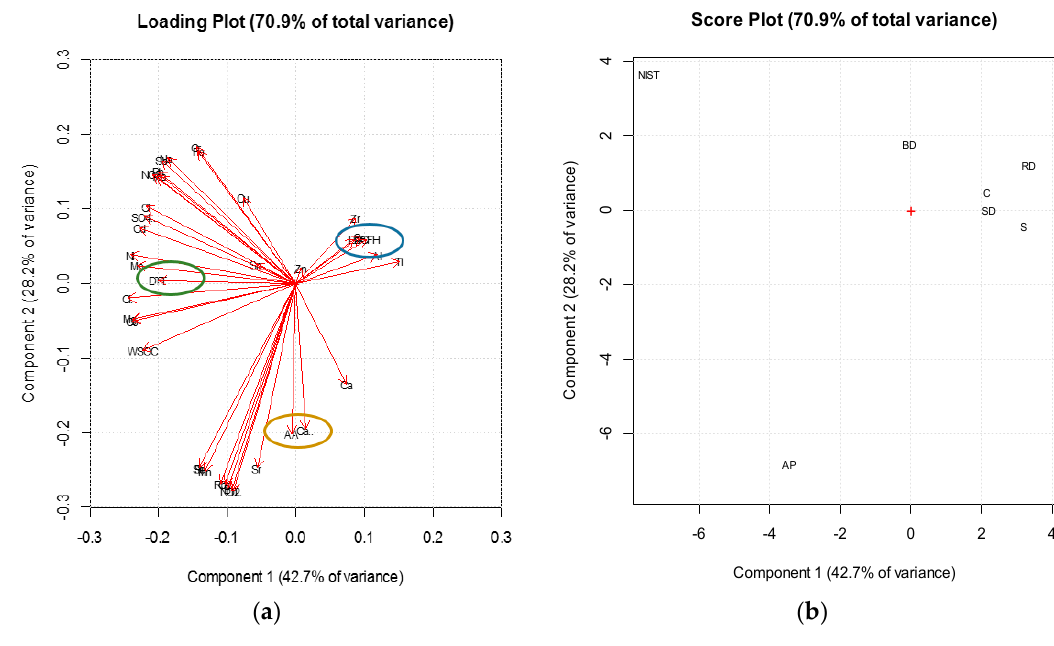
Figure 3. PCA analysis about soluble part of